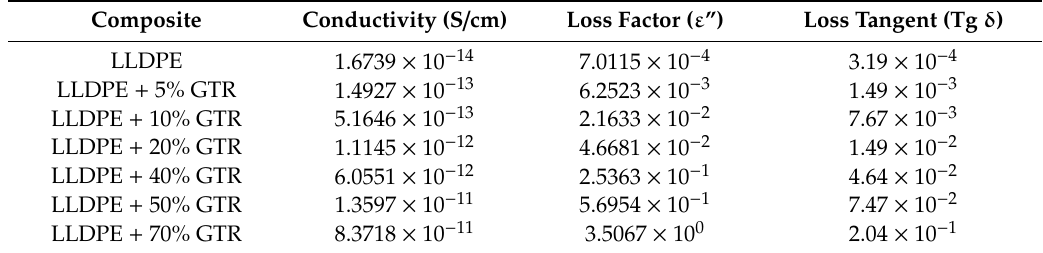
Table 3. Conductivity, loss factor and loss tangent, for each composite, at 50 Hz and 30 ◦ C.